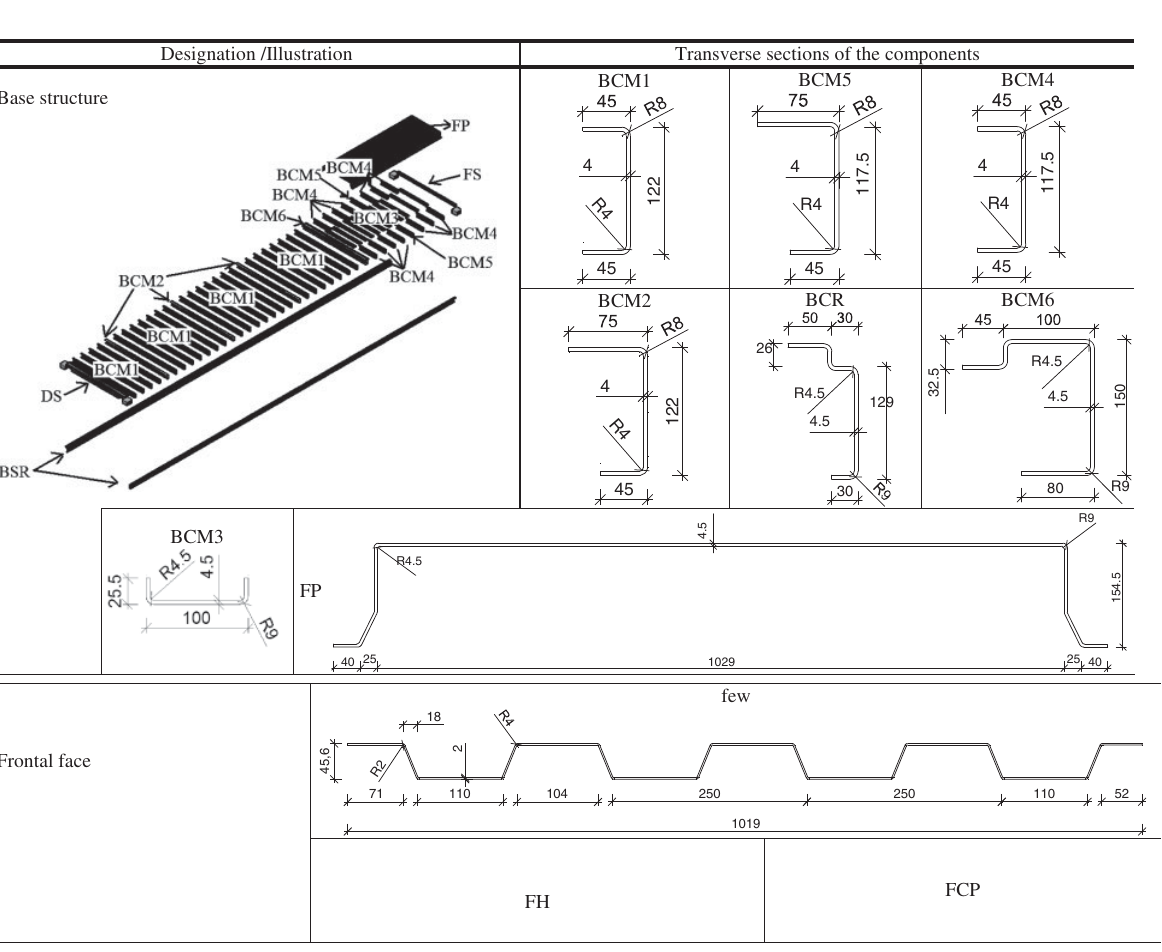
Table 3. Elements of the shipping container 40’HC